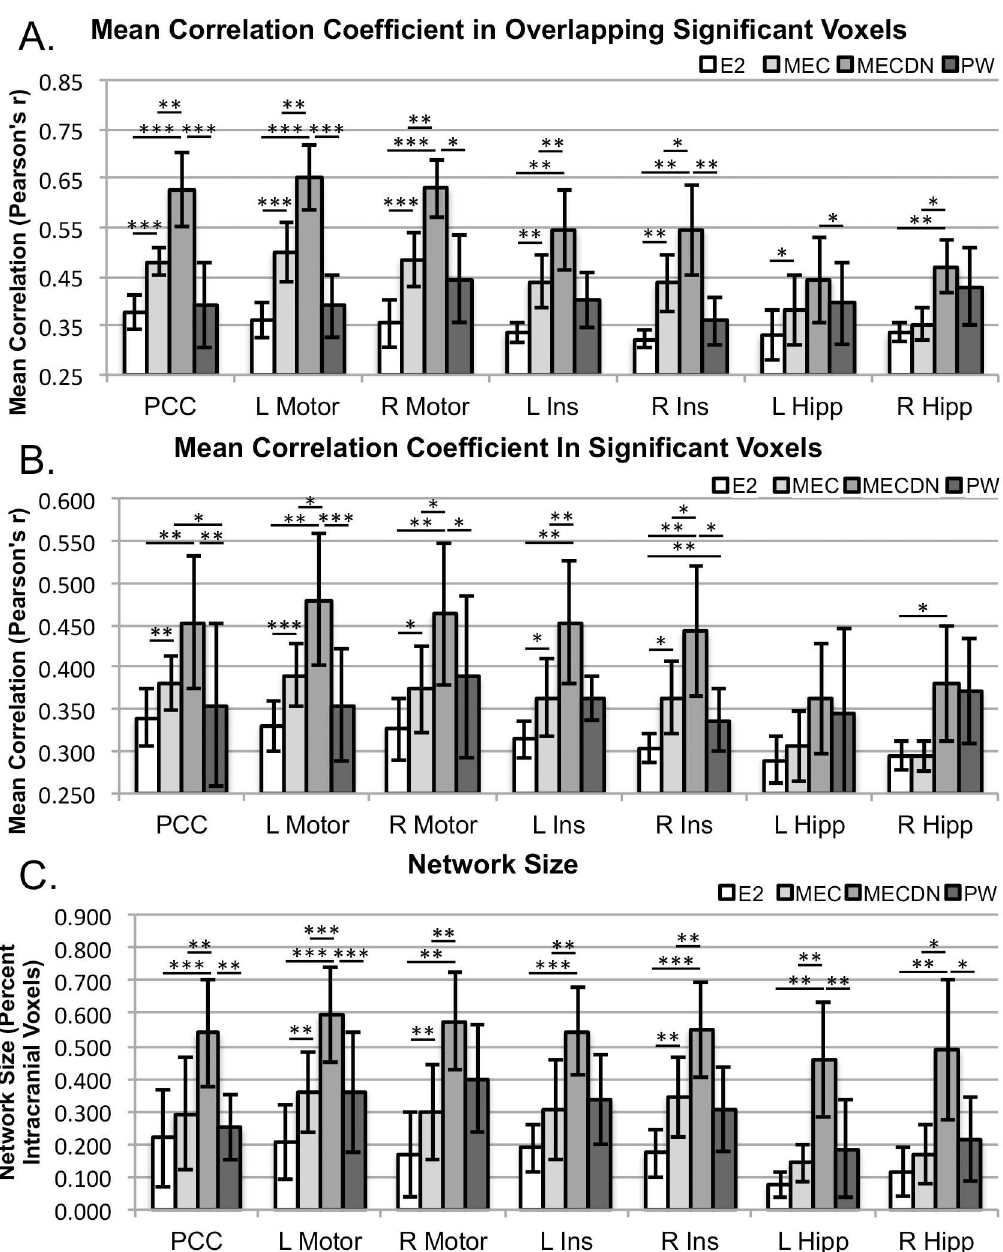
Fig 6. Quantitative results. Mean correlationin overlappingsignificantvoxels (Top), mean correlationin significant voxels for the E2, MEC, MECDN, and PW data separately(Middle), and network size, displayedas a fraction of intracranialvoxels (Bottom). Voxels with P < 0.005 and minimumcluster size = 46, α = 0.05 were considered significant.Parameters were extracted on an individualsubject basis. * = P < 0.05; ** = P < 0.01; *** = P < 0.001,